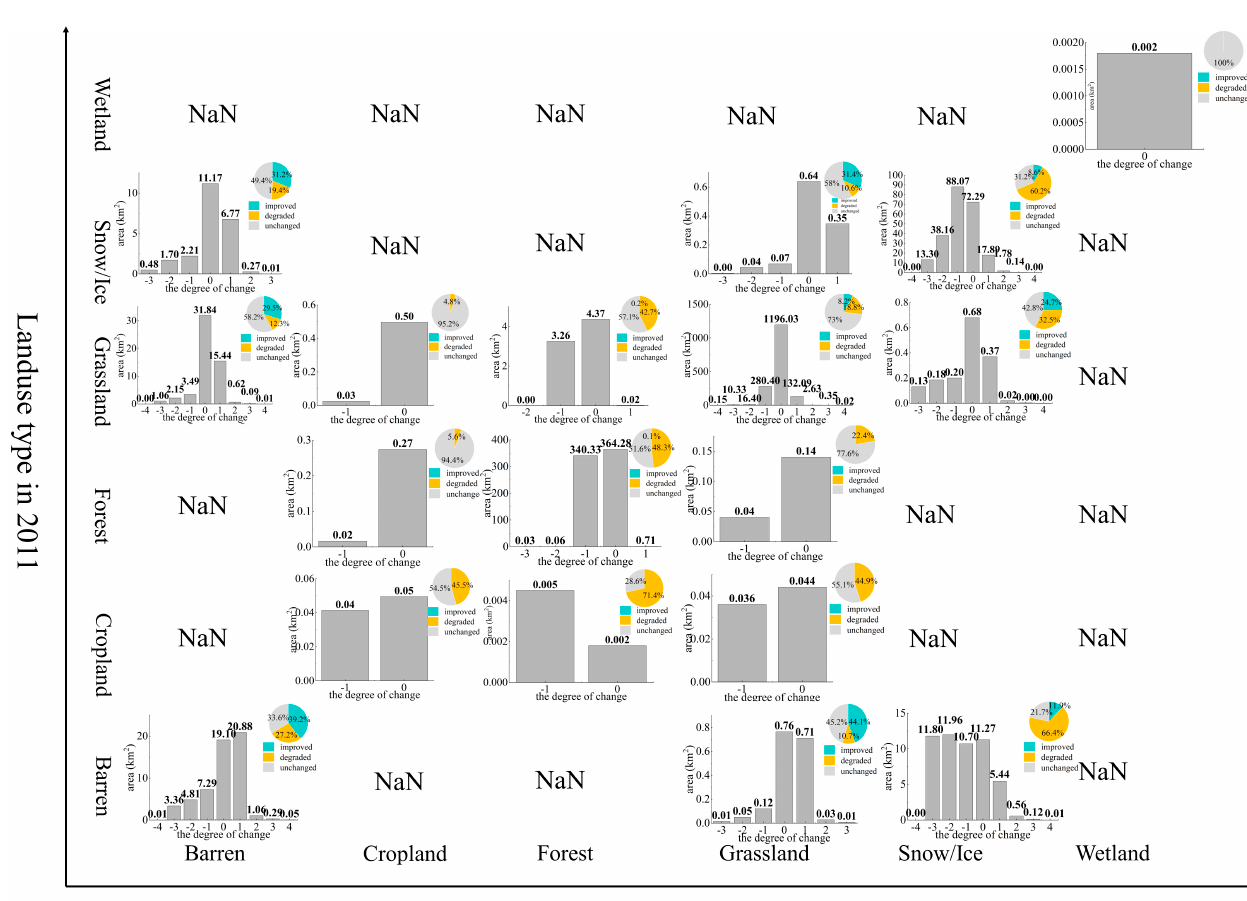
Figure 11. Statistics on the relationship between land use type change and ecological environment quality change from 2011 to 2016. NaN means there are no such observations. Taking the land use as barren in 2011 and as barren in 2016 as an example, we can see the shift area of the ecological class change caused by the barren–barren shift approach in the bar chart. At the same time, we can see the area proportion of ecological environment improvement or deterioration caused by the change in land use mode in the pie chart (bo tt om left corner of the fi gure).